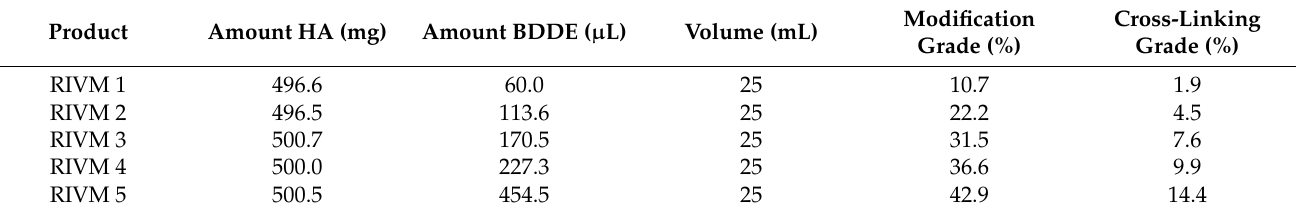
Table 8. Overview of experimental synthesized cross-linked HA. Modification and cross-linking grade were determined by liquid chromatography–mass spectrometry